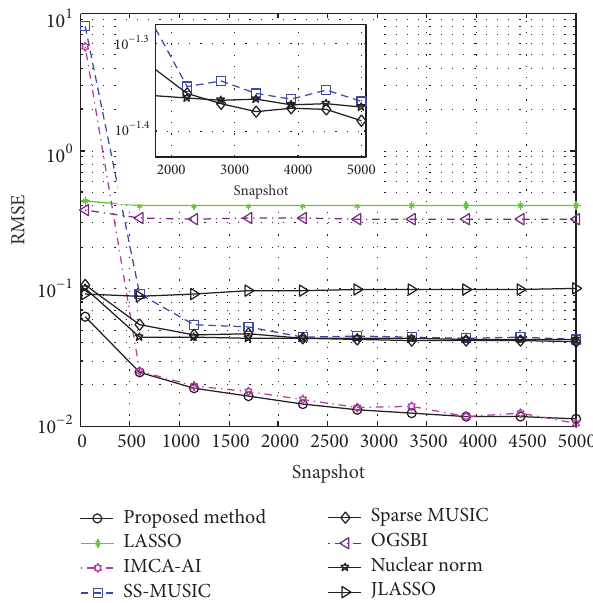
Figure 10: RMSE versus snapshot ( SNR = 0, 𝐾 = 2)